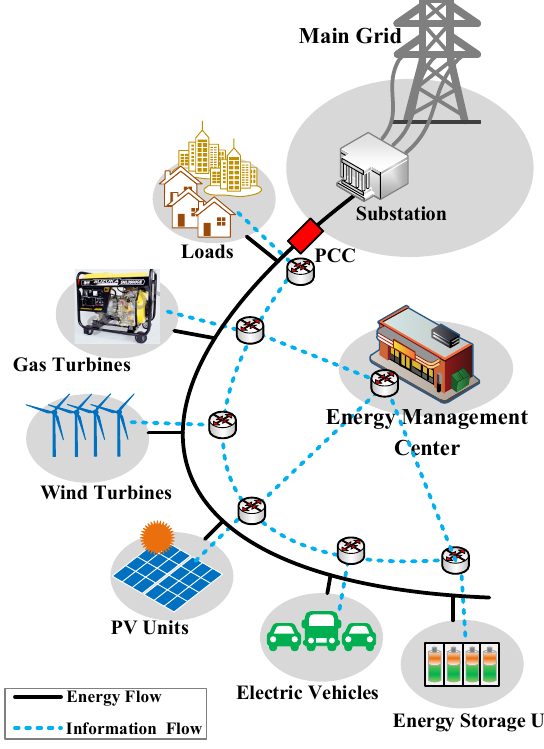
Figure 1. Configuration of a